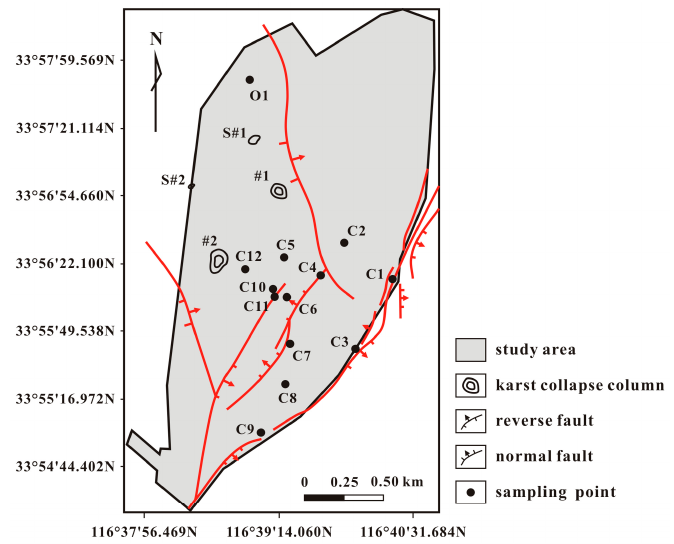
Figure 3. Locations of sampling points and karst collapse columns in the study area. S #1 and S #2 are potential karst collapse columns, while #1 and #2 are certain karst collapse